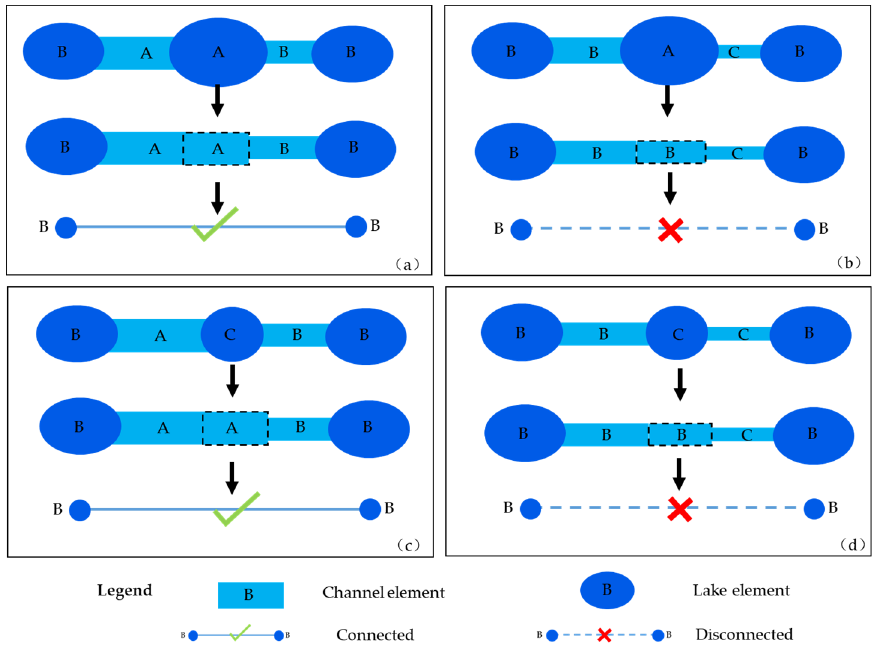
Figure 2. Judgment of the complex connected form. ( a – d ) represents the different complex connected forms. Grade A, B and C mean that the network elements (lakes and channels) are divided into different grades according to Table